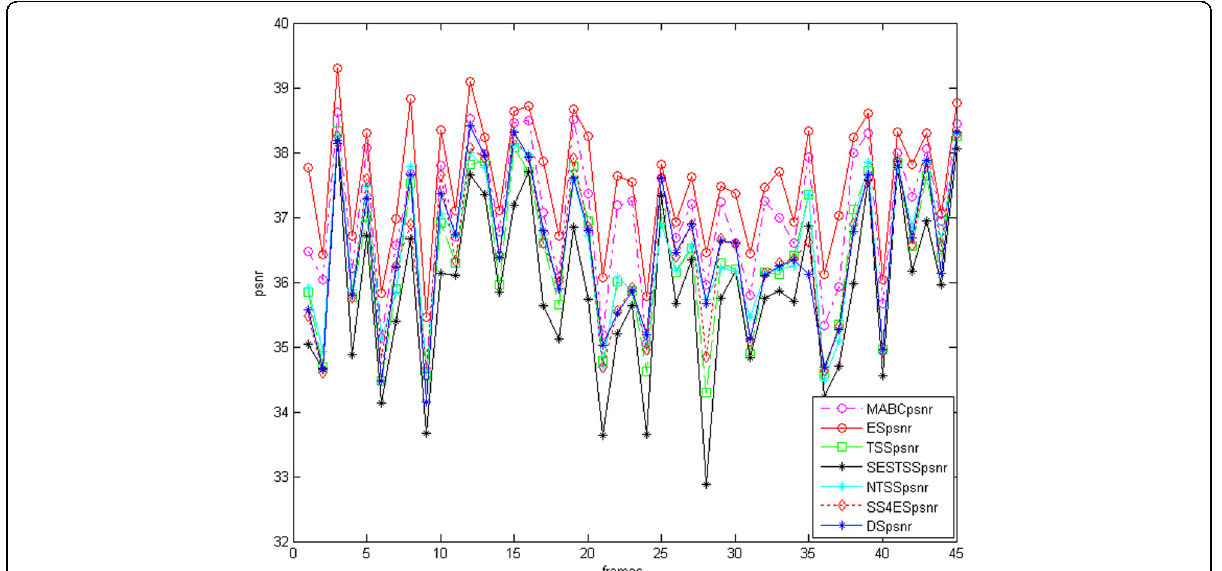
Fig. 7 Comparison of the PSNR values of the 45 frames of “ Highway.qcif